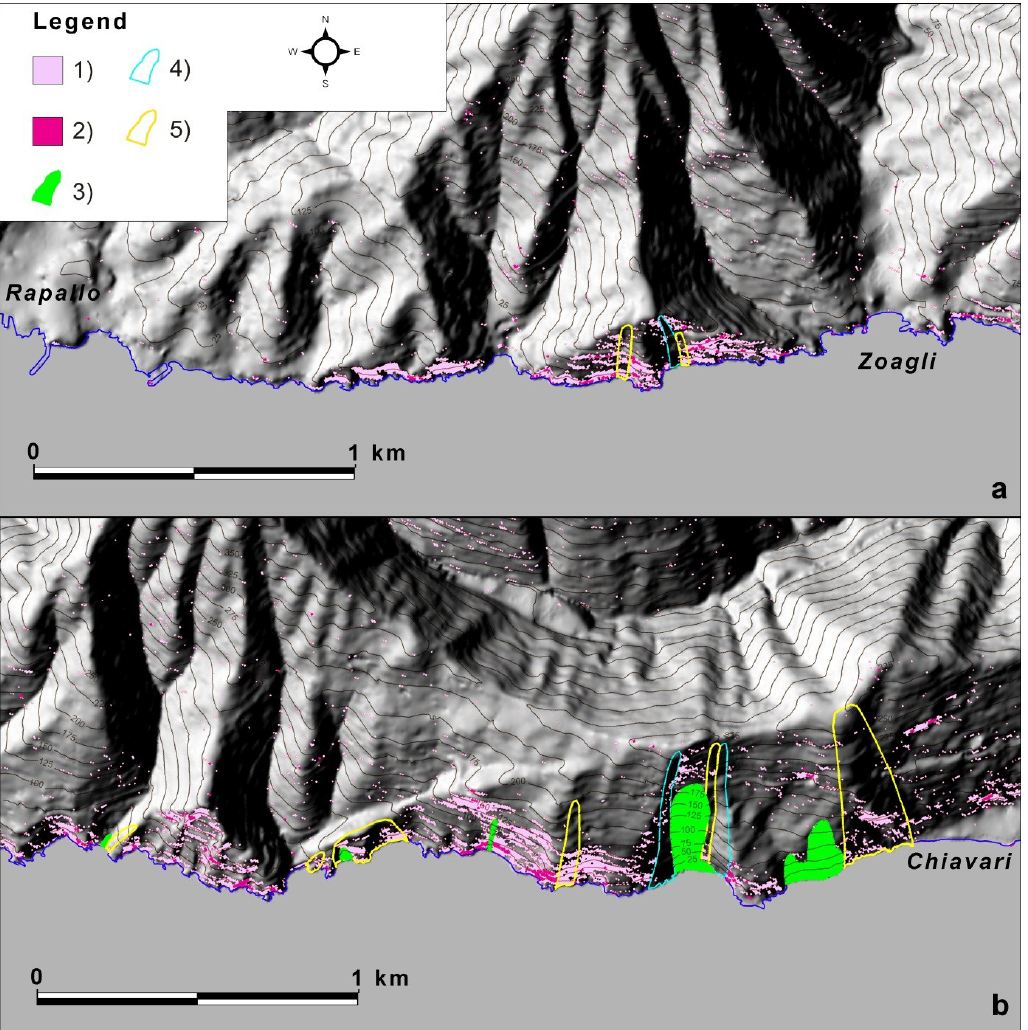
Fig. 10 Fig. 10. Rock failure susceptibility map. Legend: (1) medium susceptibility for rock slope failure; (2) high susceptibility for rock